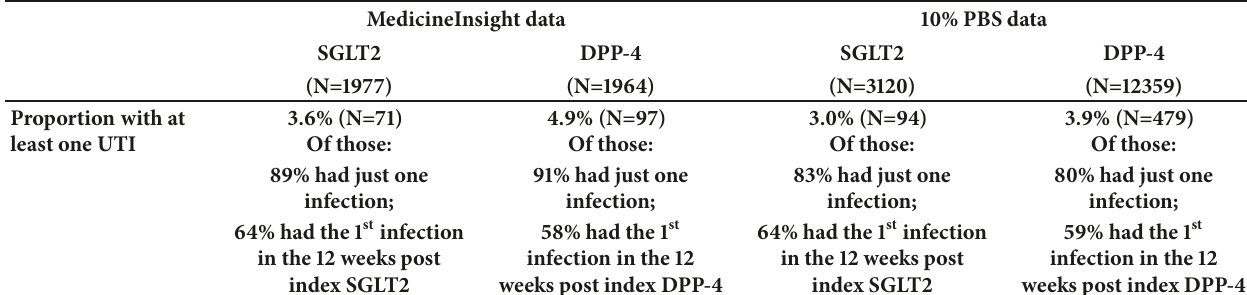
Table 3: Frequency of UTIs in the 6 months after SGLT2 or DPP-4